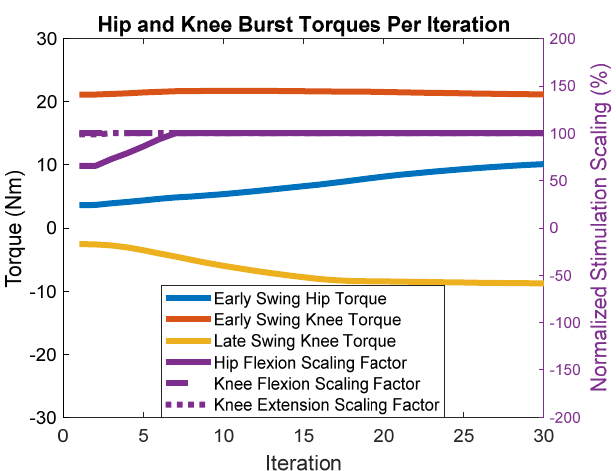
Figure 6. Muscle and motor recruitment over each iteration in the presence of simulated fatigue. The initial values of muscle and motor recruitment are based on the 30th iteration of the non-fatigue simulation.